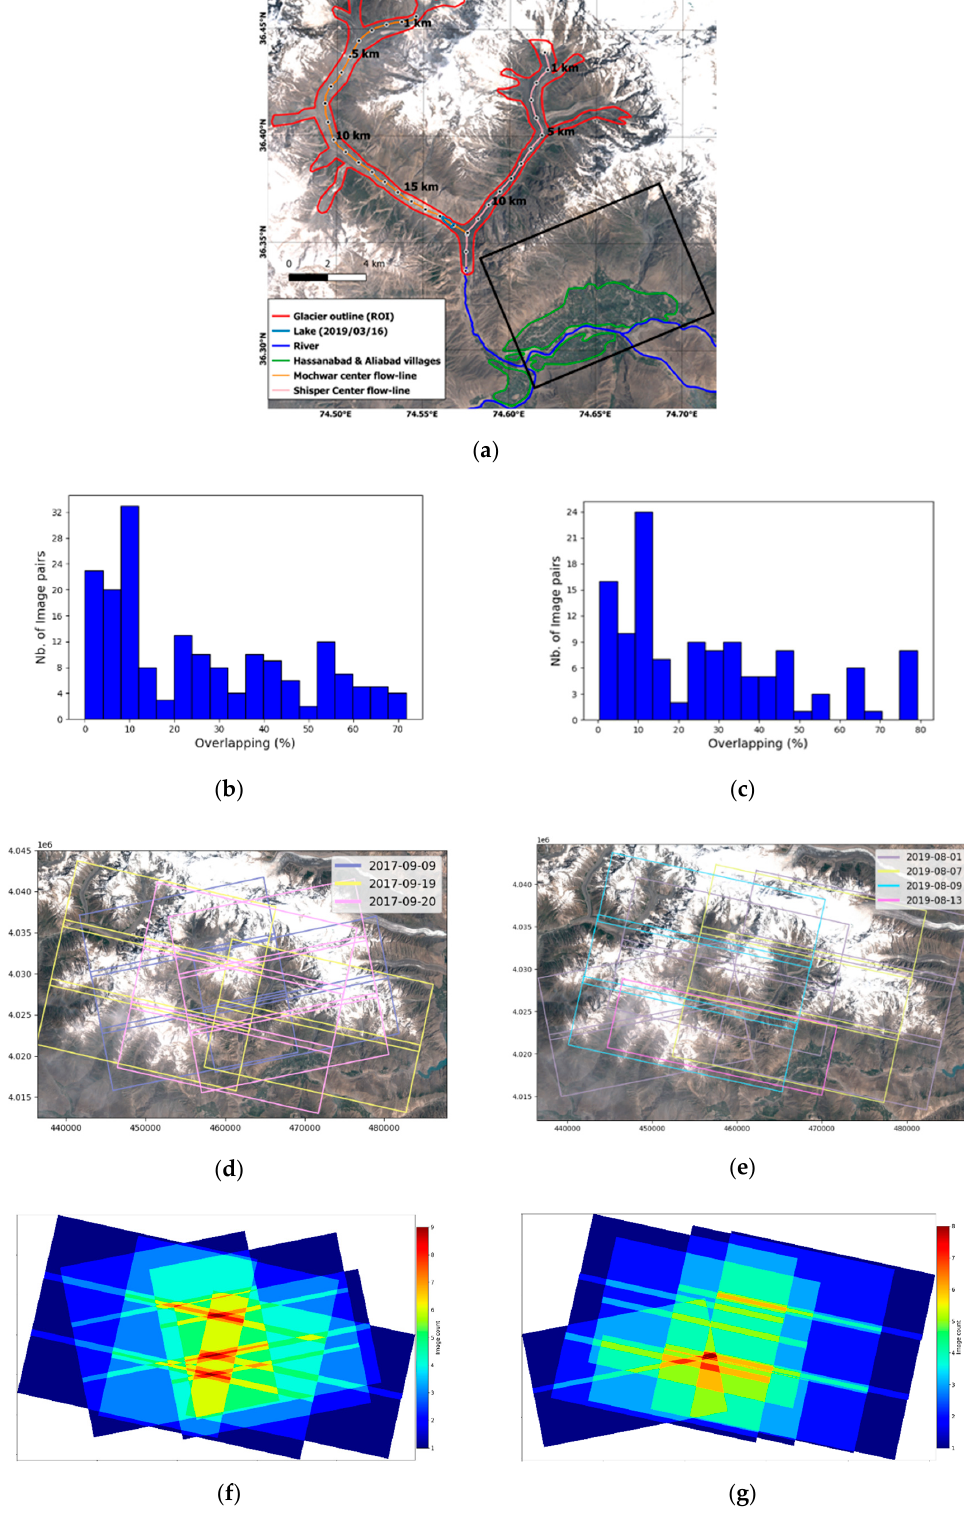
Figure 11. The test site Shisper Glacier, Karakoram, Pakistan. ( a ) Subset of Sentinel 2 true color ortho-image (TCI) over the study area captured on 16 March 2019. Randolf Glacier Inventory [41] outline of both glaciers are shown in red. Location of the ice-dammed lake is shown in light blue. Rivers are denoted in dark blue and Hassanabad village is outlined in green. ( b , c ) Histogram